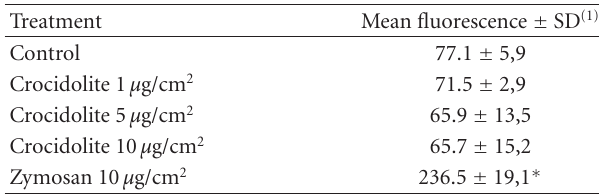
Figure 1: Time course of oxidant production by NR8383 cells after incubation with crocidolite and zymosan. Oxidant production was measured as increased chemiluminescence of lucigenin (in relative light units, RLU). Each point represents the mean ± SD of three experiments. Control ( ∗ ); Crocidolite 15 μ g/cm 2 ( (cid:2) ), 30 μ g/cm 2 ( (cid:3) ), and 60 μ g/cm 2 ( ◦ ); Zymosan 7.5 μ g/cm 2 ( (cid:4) ), 15 μ g/cm 2 ( (cid:5) ), and 30 μ g/cm 2 ( • ). Table 2: DCF fluorescence in particle-exposed NR8383 analysed by flow